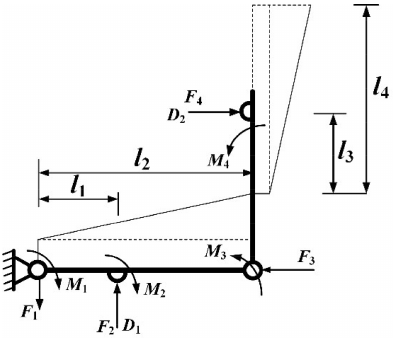
Figure 7. Analysis diagram of the compliant lever